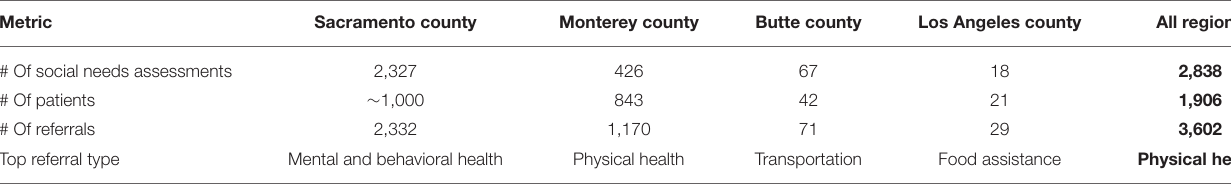
TABLE 1 | High-level data from the CHA program through December 2020 is outlined below.